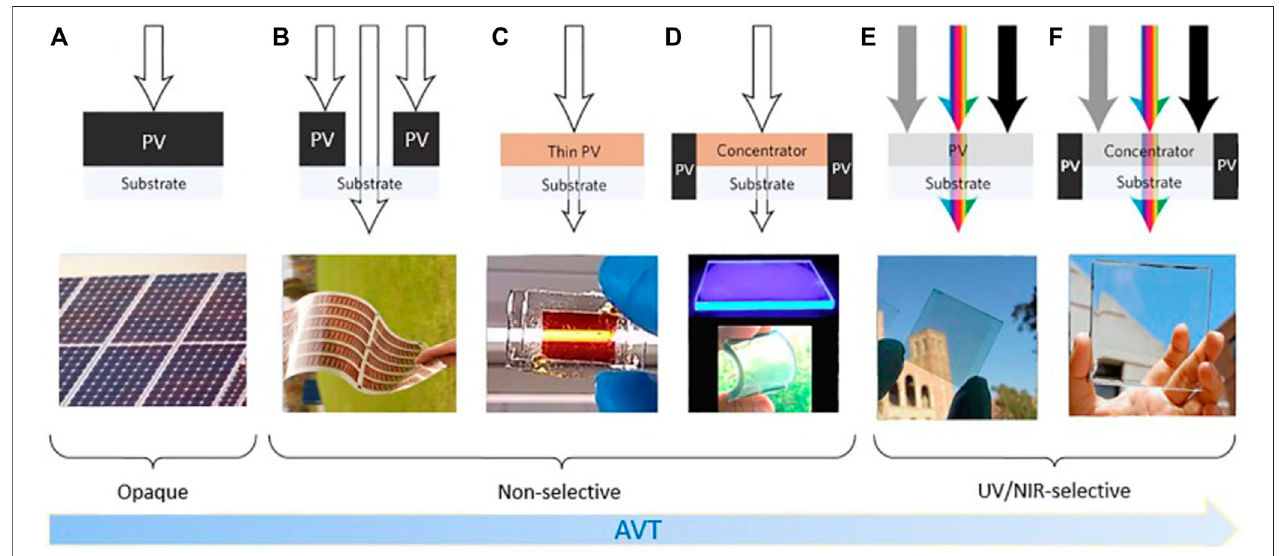
FIGURE 3 | Average wavelength-selective technologies for PV greenhouse materials (Pulli et al.,